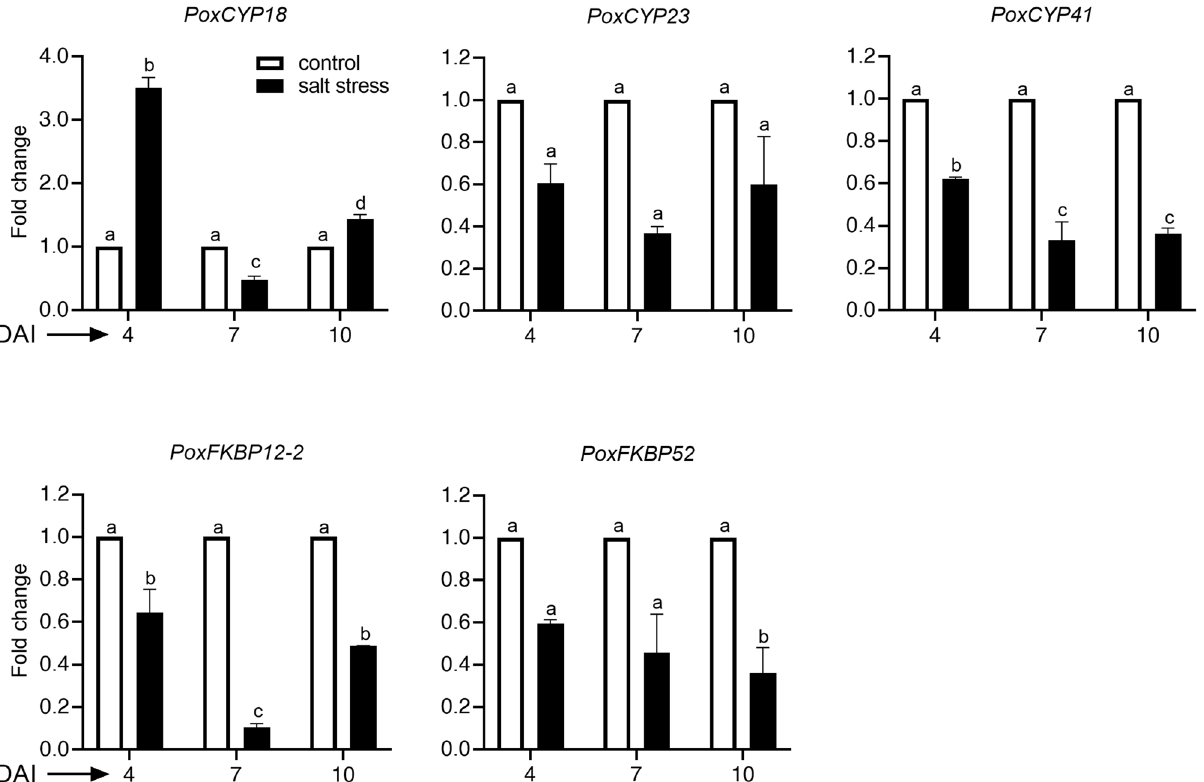
Figure 5. Effect of salt stress (15% NaCl) on expression of cyclophilin and FKBP genes in the mycelia of Penicillium oxalicum. Changes in the transcript levels were estimated by Real-time PCR analysis using ACTIN gene as reference. The fold change presented is with respect to the control lacking NaCl. The values depict the mean of three biological replicates ± standard error and are significant at P ≤ 0.01 (Tukey-HSD test; α = 0.05). The values with distinct letters are significantly different. (DAI: days after